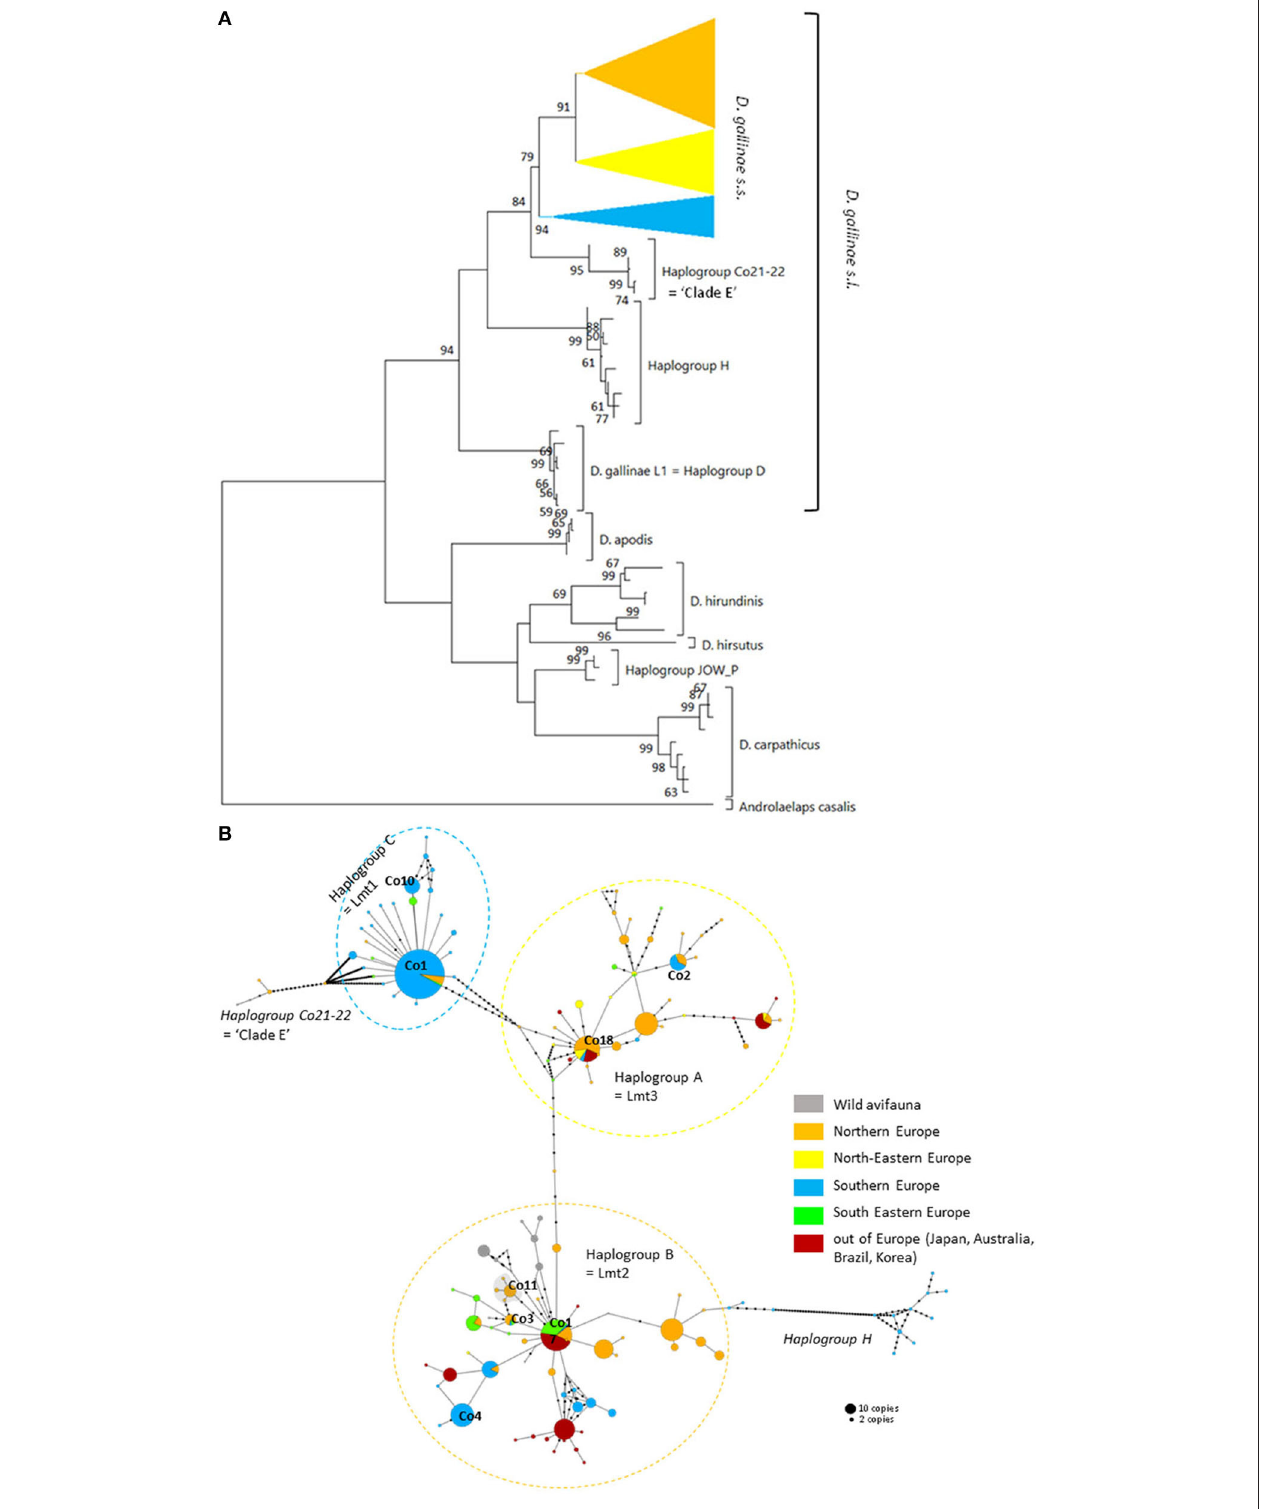
FIGURE 3 | Genetic structure from CO1 haplotypes on region 1. (A) Evolutionary history of the different region-1 haplotypes obtained to date from the genus Dermanyssus with condensed clades within D. gallinae s.s (132 sequences) and Androlaelaps casalis (Mesostigmata: Dermanyssoidea) as an outgroup. A single